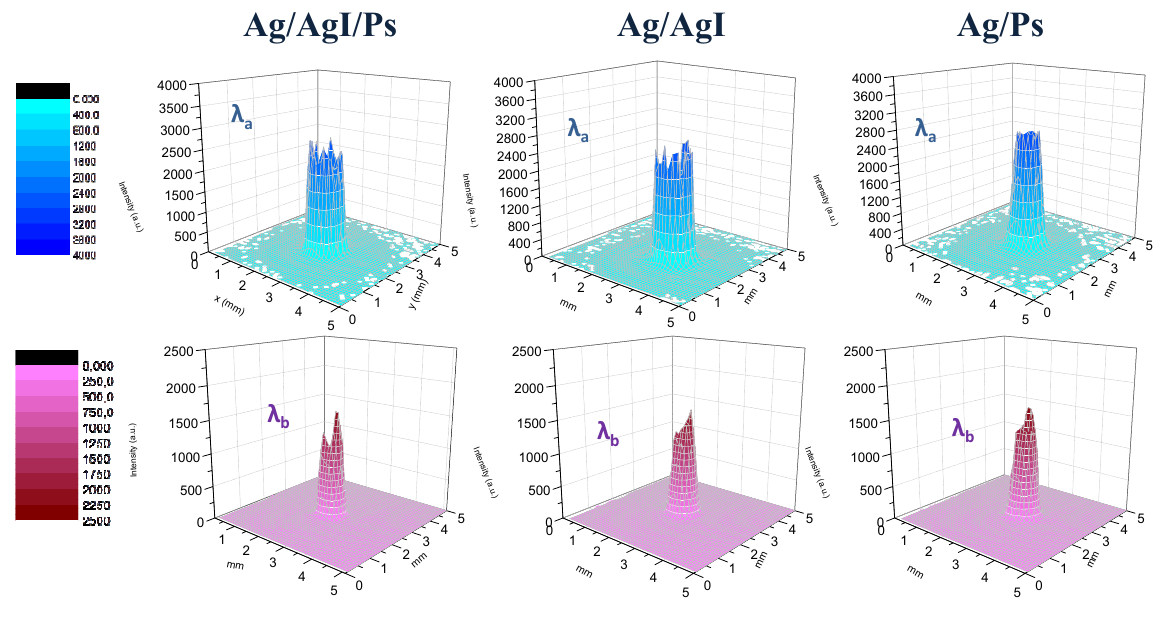
Figure 5. Far-Field spatial intensity distribution of the λ upon exiting a 12 cm long and 1 mm bore diameter hollow waveguide having AgI/Ps double dielectric layer and having a single dielectric film of AgI and Ps. The beam profiles have been measured in a back-to-back